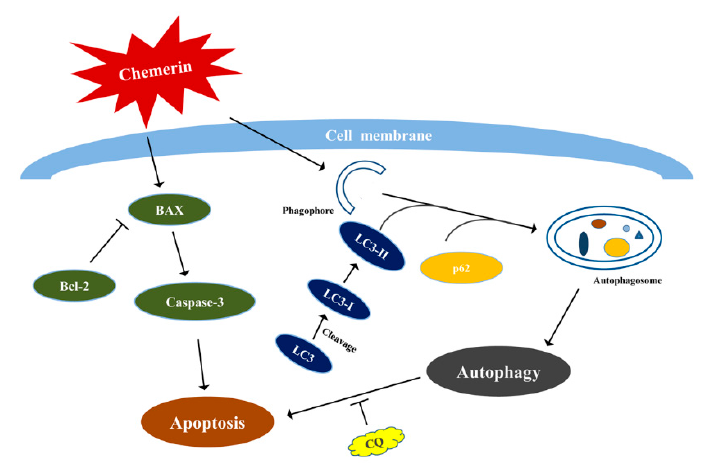
Figure 6. A schematic illustration of the role of Chemerin in BMECs. Chemerin induced autophagy through promoting degradation of p62 and conversion of LC3I to LC3II. Chemerin also induced apoptosis by up-regulation of the Bax / Bcl-2 and activating caspase-3. In addition, there was a complex interplay between apoptosis and autophagy under Chemerin treatment, CQ pretreatment could effectively inhibit autophagy and aggravate apoptosis.